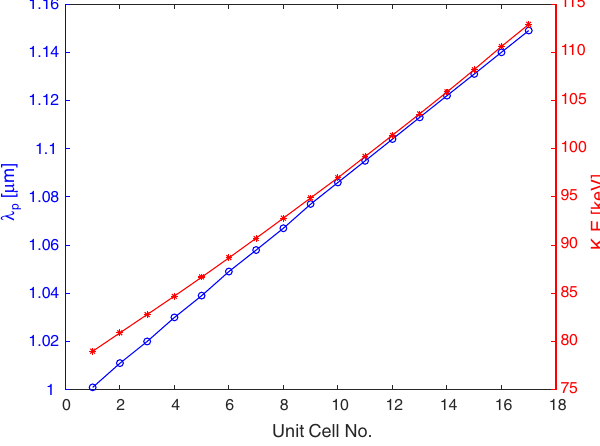
FIG. 3. Unit-cell length (blue, circles) and corresponding kinetic energy (KE) (red, stars) for a 17-cell tapered MLA designed for an initial energy of 79 keV and an incident field amplitude of 0 . 5 GV = m.